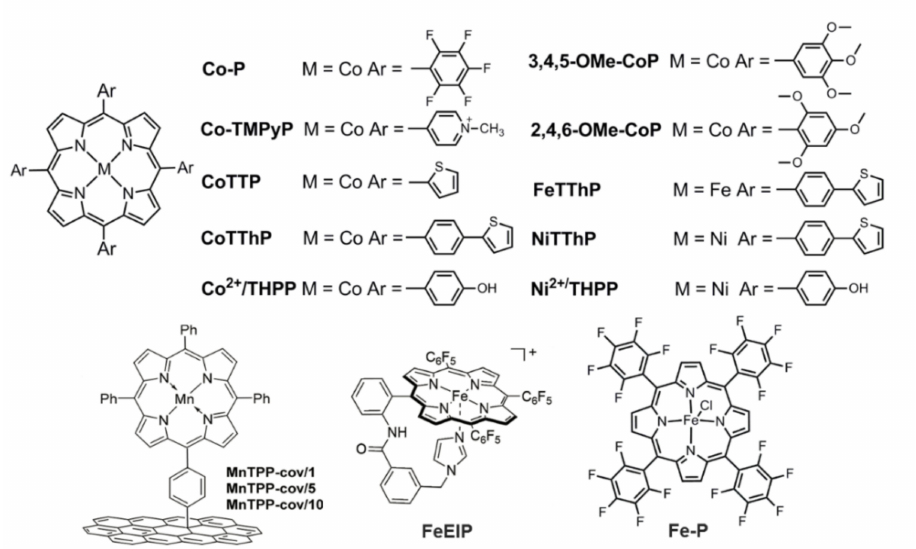
Figure 14. Porphyrin-based small molecules for bifunctional oxygen electrocatalysts. Reproduced from ref. [91–98].